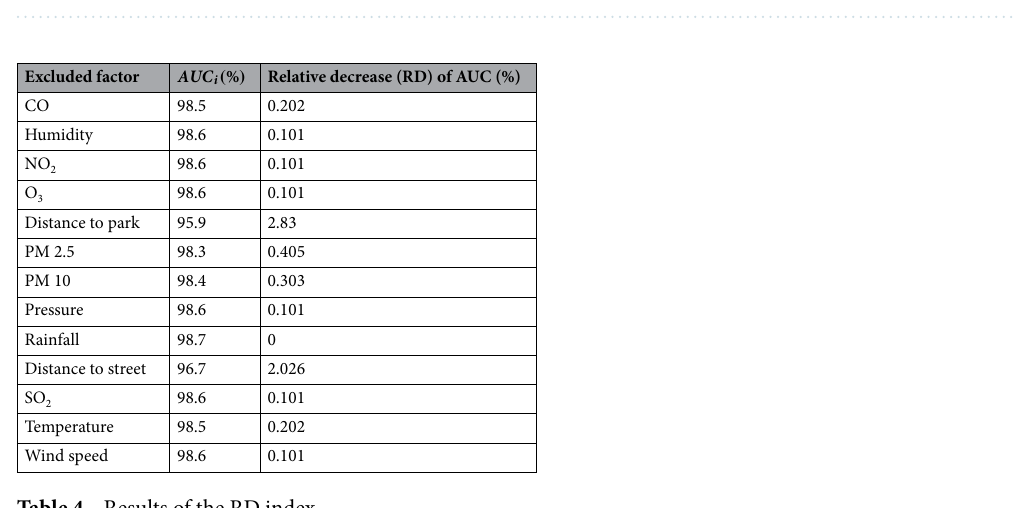
Figure 9. Asthma-prone areas mapping by RF model. This map was generated using the tool of ArcGIS 10.3 (ESRI, Redlands, CA, USA, http://www.esri.com).